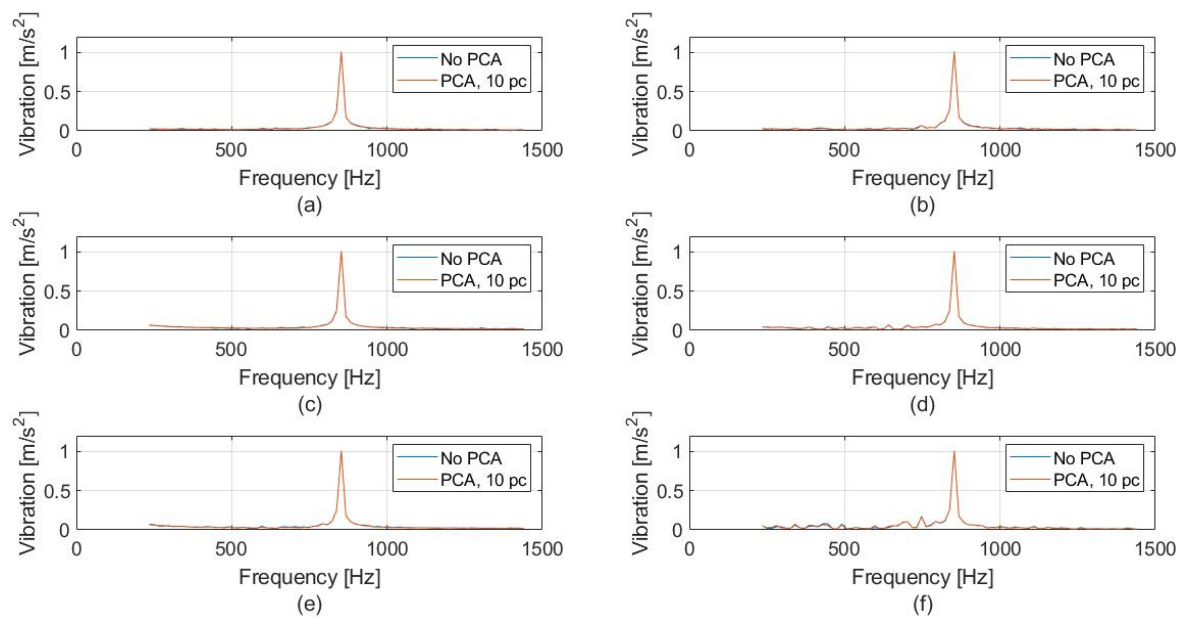
Figure 19. A comparison among the original FFT and the reconstructed FFT with 10 principal components: ( a ) Undamaged, ( b ) damage = 0.2, ( c ) damage = 0.35, ( d ) damage = 0.48, ( e ) damage = 0.63, ( f ) damage = 1.